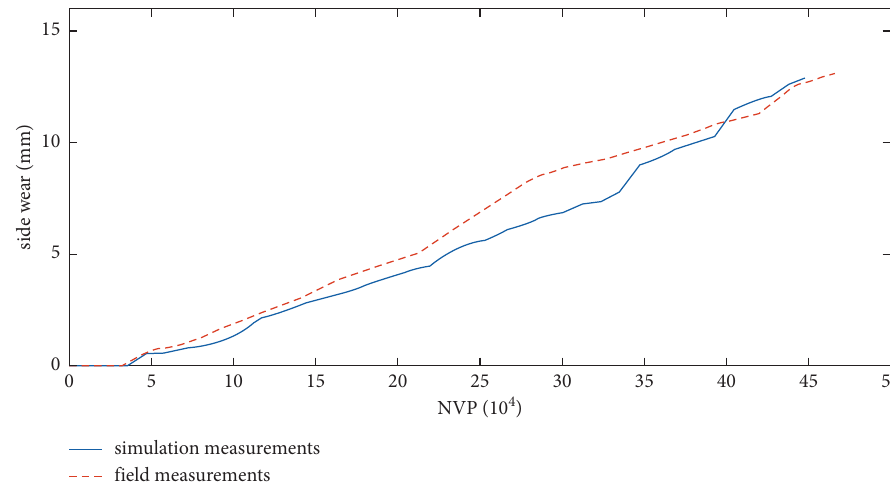
Figure 2: Measured and simulated wear